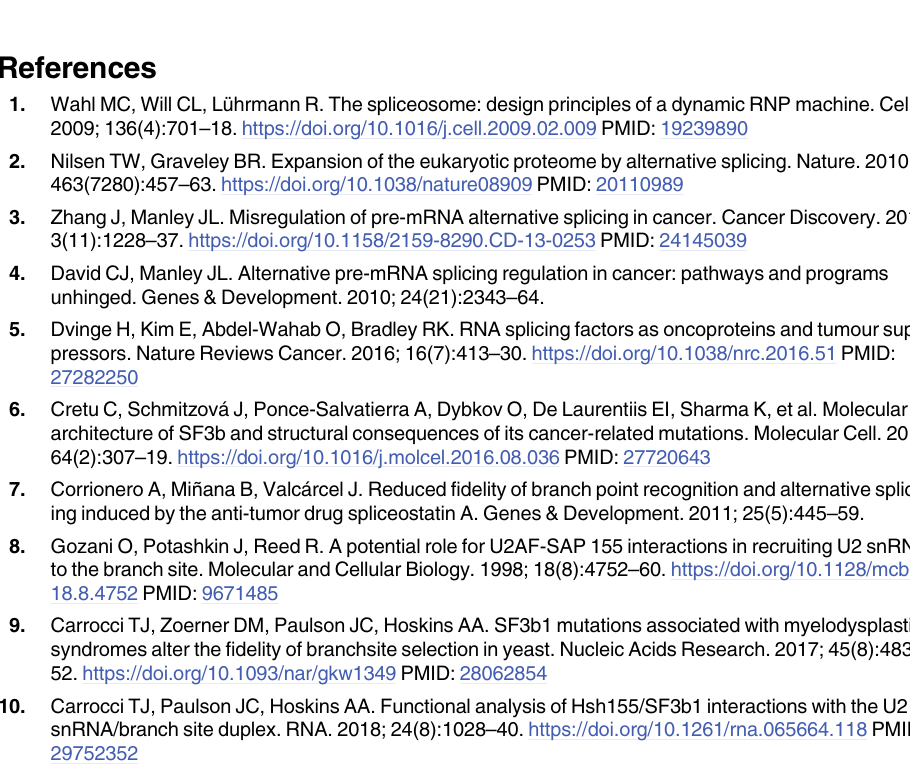
S1 Table. Yeast strains used in this study. S2 Table. Plasmid used in this